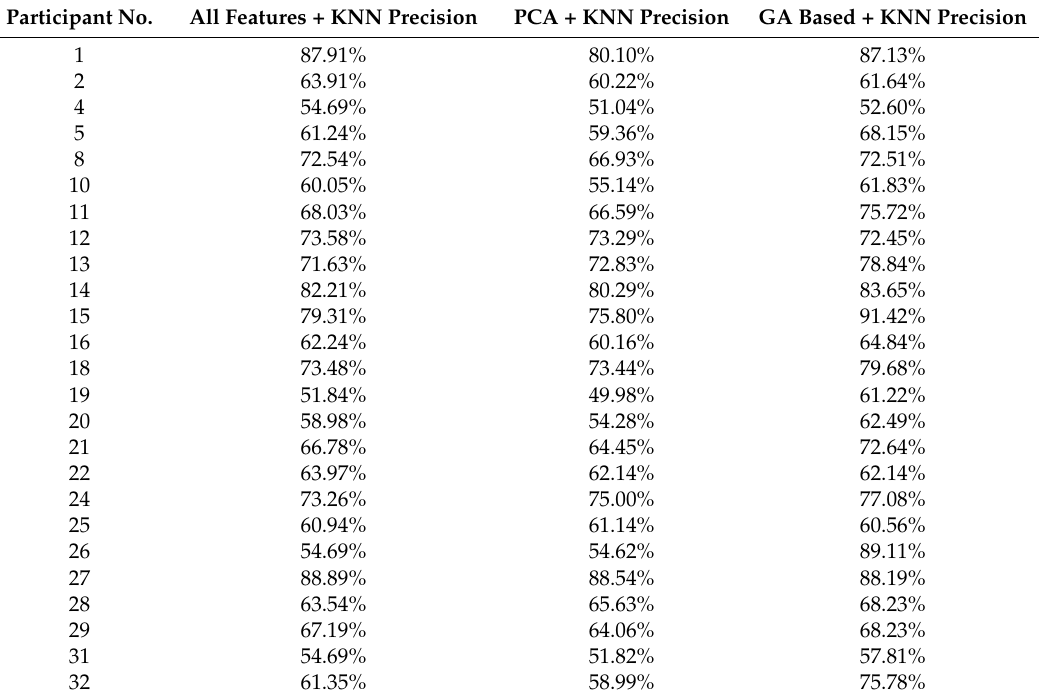
Table 3. Classification performance of the three different methods for feature